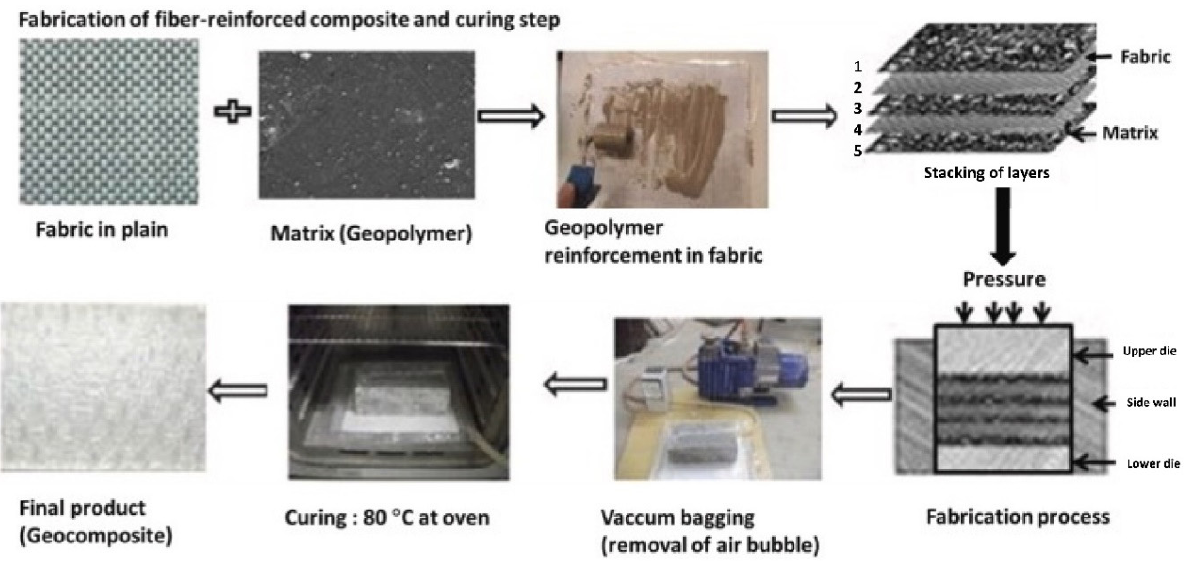
Figure 5. Fabrication steps for carbon fiber reinforced geopolymer composite with stacking sequence, with the follow-up curing process.